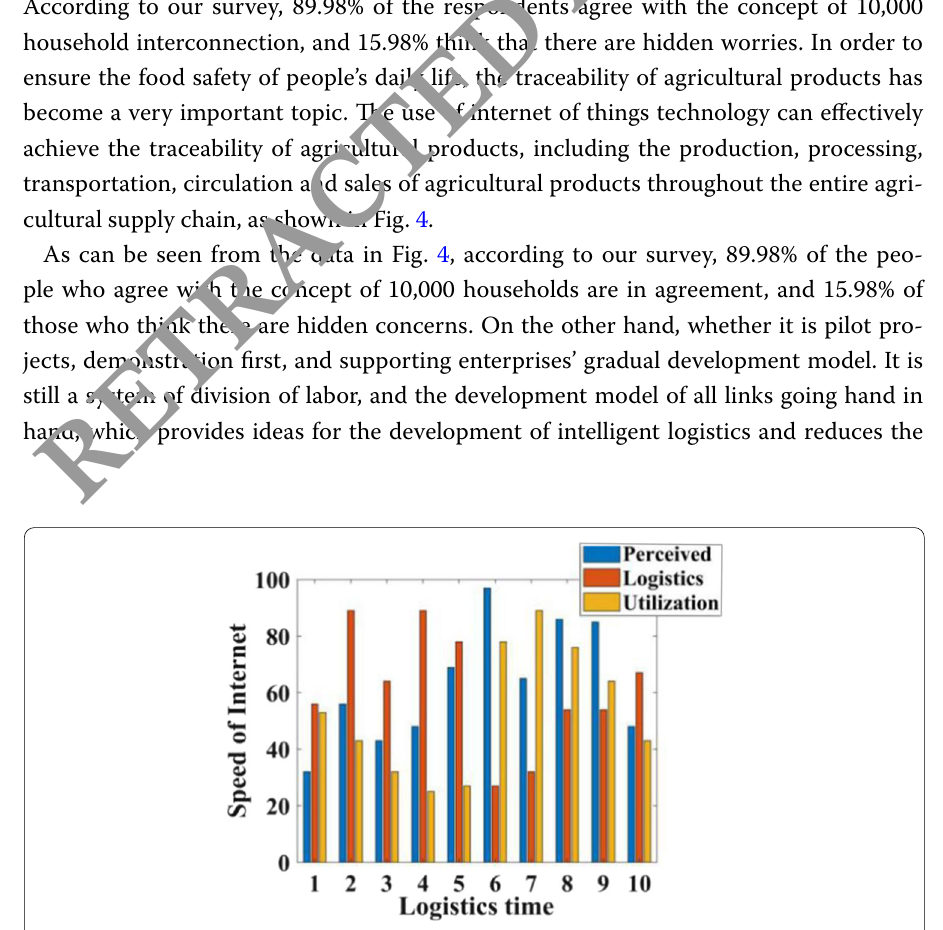
Fig. 3 Stability data of tennis balls and rackets made of fiber nanocomposites under electrostatic spinning technology at high